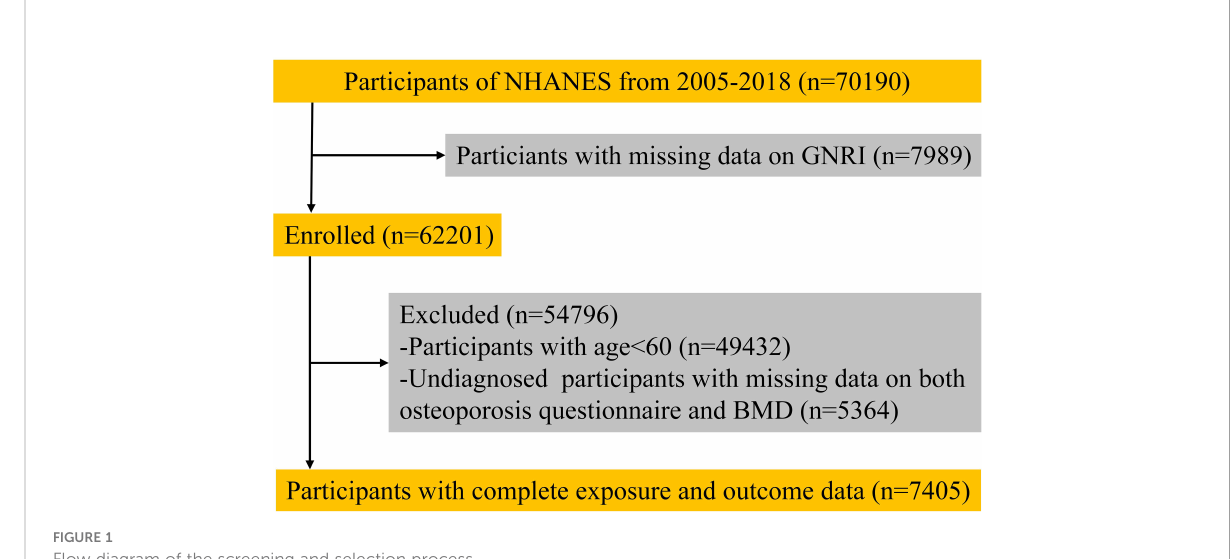
FIGURE 1 Flow diagram of the screening and selection